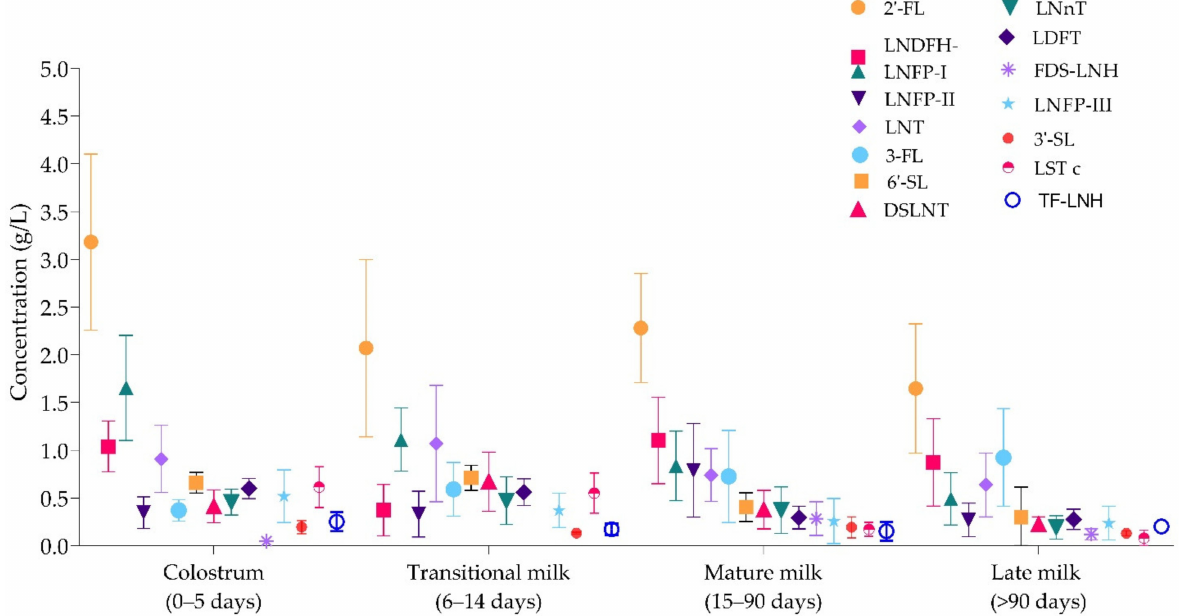
Figure 2. Overview of the 15 most abundant HMOs throughout the pre-defined lactation periods. The individual HMOs resulting from the review were categorized and summed according to their HMO group (neutral core, fucosylated, or sialylated). Figure 3 shows that the fucosylated sum remains the most abundant HMO portion compared to sialylated and neutral core group.